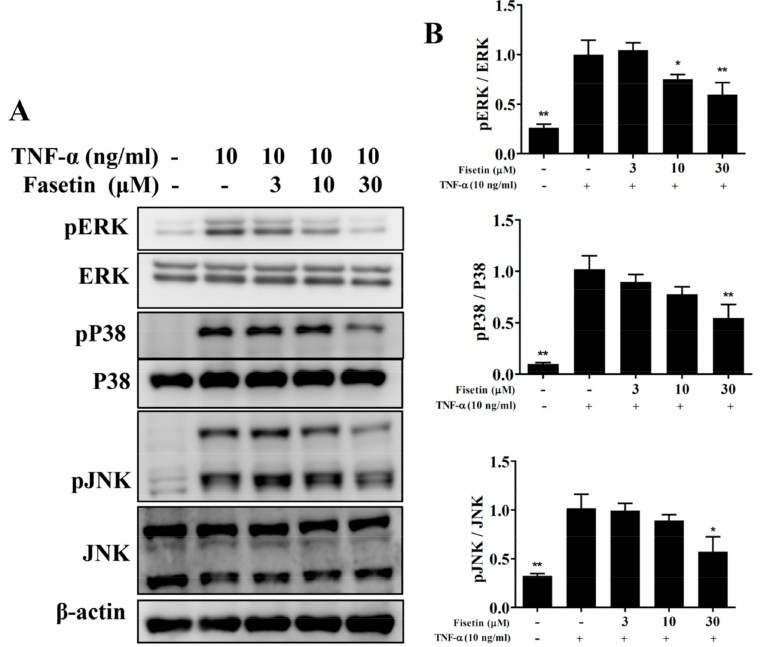
Figure 5. MAPK phosphorylation suppressed by treatment with fisetin in TNF- α -induced BEAS-2B cells. ( A ) Phosphorylated levels of ERK, JNK, and p38 proteins ( n = 3 per group). ( B ) The fold expression of pERK, pP38, and pJNK measured relative to the expression of ERK, P38, and JNK, respectively. The data are presented as mean ± SEM of three independent experiments. * p < 0.05, ** p < 0.01, compared to the TNF- α -stimulated BEAS-2B cell